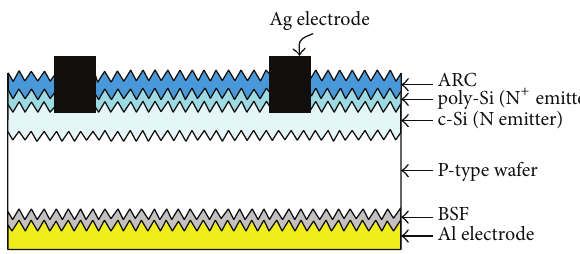
Figure 2: Cross-sectional sketch of the solar cell in group